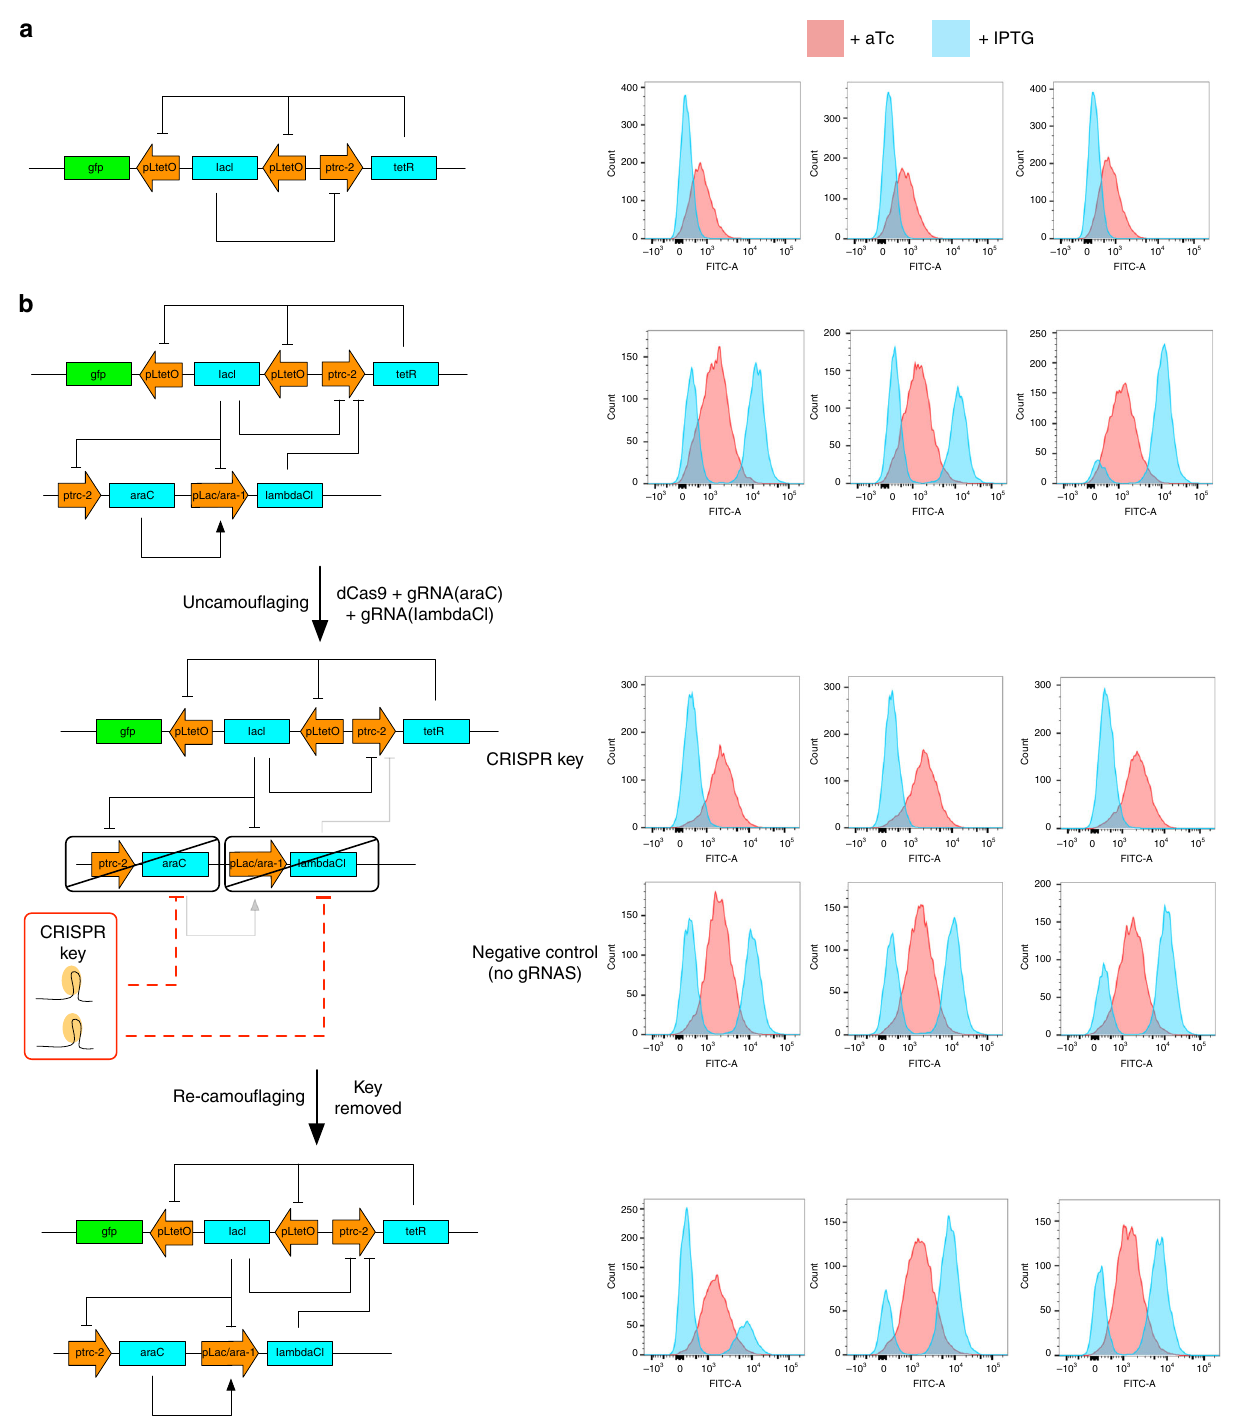
Fig. 4 Camou fl aging and uncamou fl aging of a bi-stable switch using circuit camou fl age. a The bi-stable switch is formed from tetR and lacI repressing each other. GFP serves as a reporter. b The additional genes araC and λ CI interconnect with the circuit and camou fl age it by changing the topology and interfering with its function. The addition of the CRISPR key represses expression of araC and λ CI , uncamou fl aging the switch. The dynamics of the uncamou fl aged switch are comparable to the circuit without the addition of camou fl aging genes. Removal of the CRISPR key re-camou fl ages the switch. Flow cytometry data shows the GFP output of the switch. Cells induced with + aTc are represented as red histograms, cells induced with + IPTG are represented as blue histograms. Each stage was performed in triplicate — each histogram represents one biological replicate. Additional histograms at the uncamou fl aging stage are negative controls (see Methods for